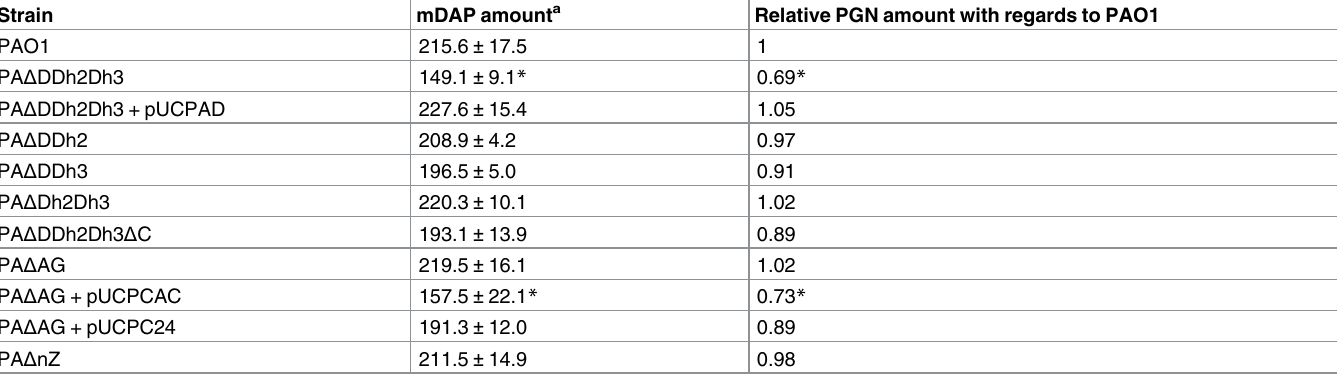
Table 2. Peptidoglycan (PGN) quantification through the titration of meso-diaminopimelic acid (mDAP).